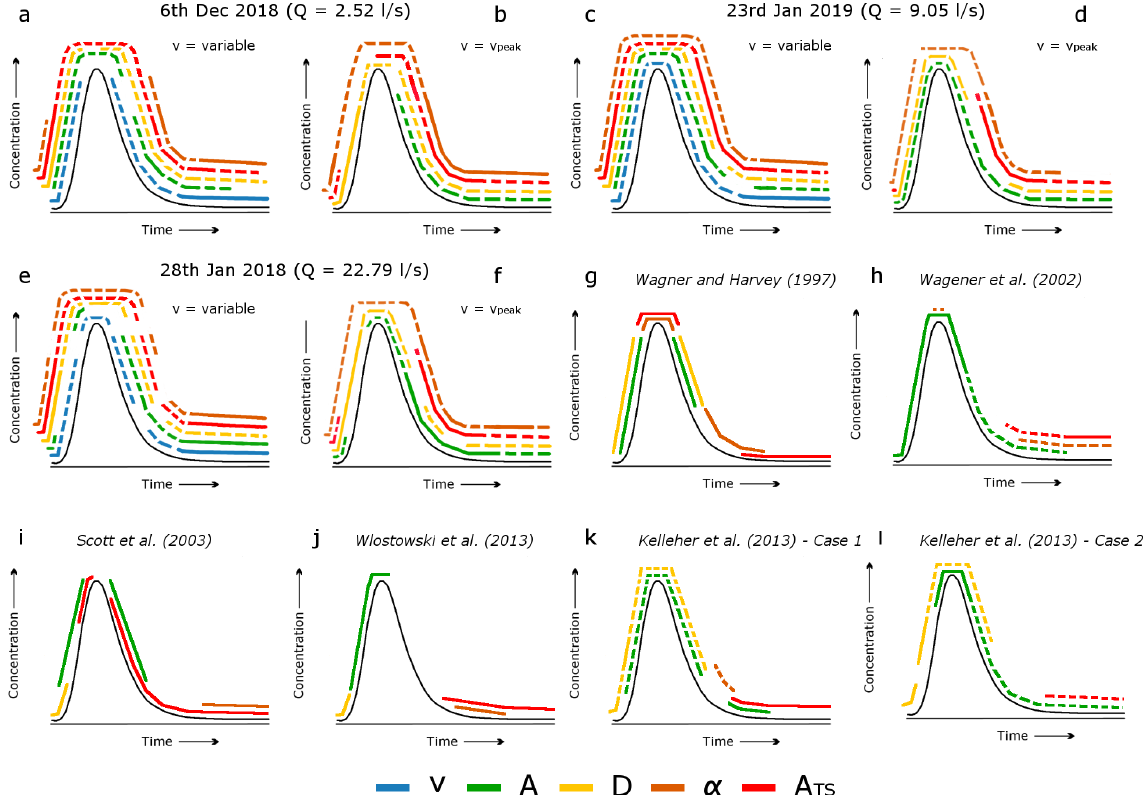
Figure 8. Qualitative plots of the TSM parameter influence different sections of the BTC. (a, b) Qualitative parameter information content on the BTC for E1, (c, d) E2, and (e, f) E3. In plots (a–f) solid lines indicate an information content above 0.66, while dashed lines indicate an information content between 0.33 and 0.66. (g) Wagner and Harvey (1997): parameter influence described via sensitivity evaluation (cf. p. 1733, Wagner and Harvey, 1997), and therefore the parameter influence is described using only solid lines. (h) Wagener et al. (2002b): plot (h) has been modified from Fig. 7 in Wagener et al. (2002b) in order to fit our 0.66 and 0.33 threshold classification in terms of information content. (i) Scott et al. (2003): parameter influence described via dimensionless sensitivity (cf. Table 1 in Scott et al., 2003), and therefore the parameter influence is described using only solid lines. (j) Wlostowski et al. (2013): plot (j) describes the parameter influence after the dynamic identifiability analysis; however, information content plots were not reported by the authors, and therefore the solid lines indicate the areas for the best-performing parameters as indicated in Fig. 2 of Wlostowski et al. (2013). (k) Kelleher et al. (2013) for the case of a dispersive mountain stream (Case 1) and (l) Kelleher et al. (2013) for the case of a small low-flow mountain stream (Case 2). Plots (k) and (l) indicate by solid and dashed lines whether the parameters influence the model output by itself or through interactions (cf. Sect. 6.1, Kelleher et al.,